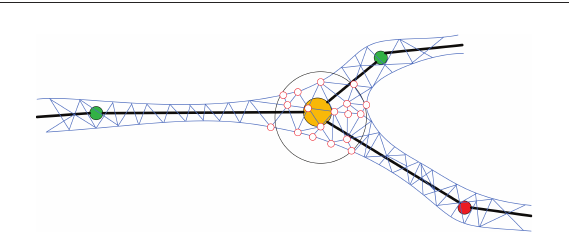
FIGURE5 Mapping mesh vertices to the skeleton. For each position on the skeleton, an ROI (e.g., the hollow black sphere) is defined based on the local radius of the skeleton. All the mesh vertices inside of the ROI (e.g., the hollow red circles) are mapped to the current skeletal position and will be deformed